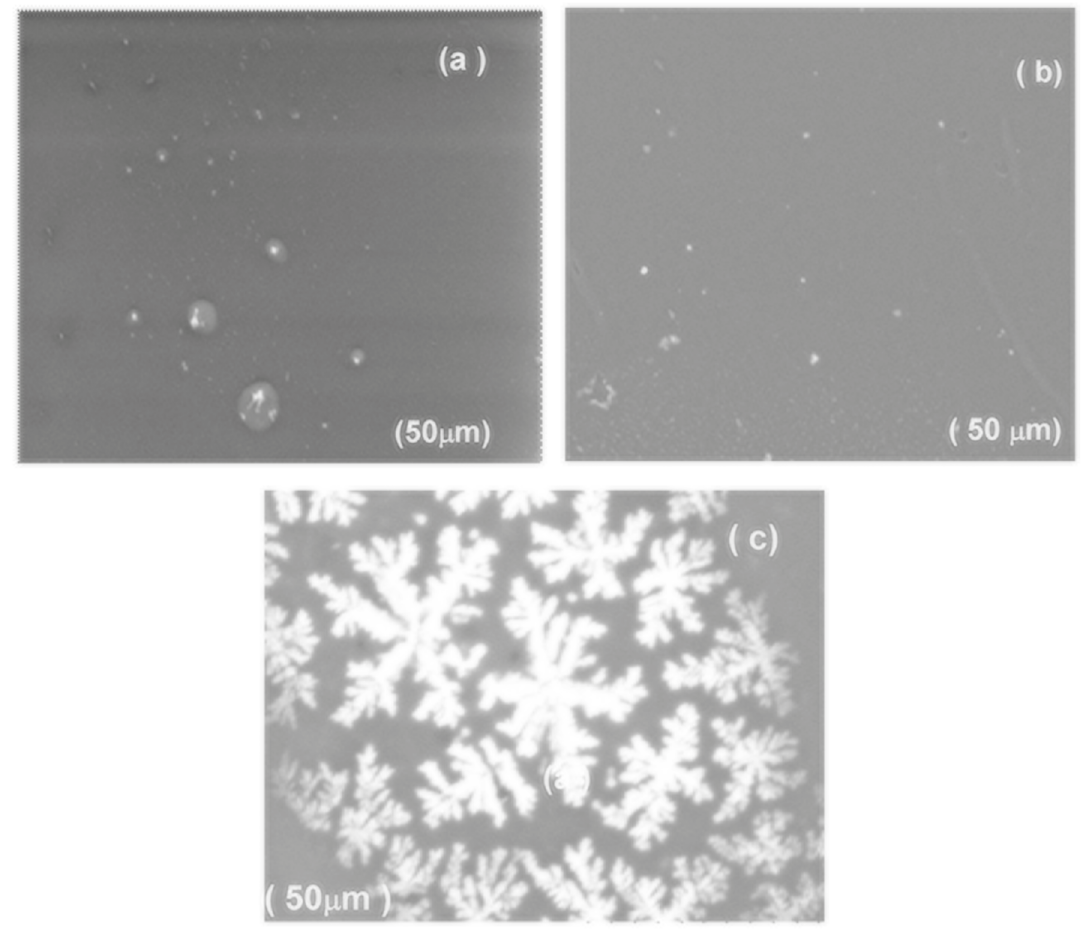
Figure 8. SEM images of (a) Pure MAA:EA (b) Pure PVA (c) PVA/MAA:EA (50:50) blend